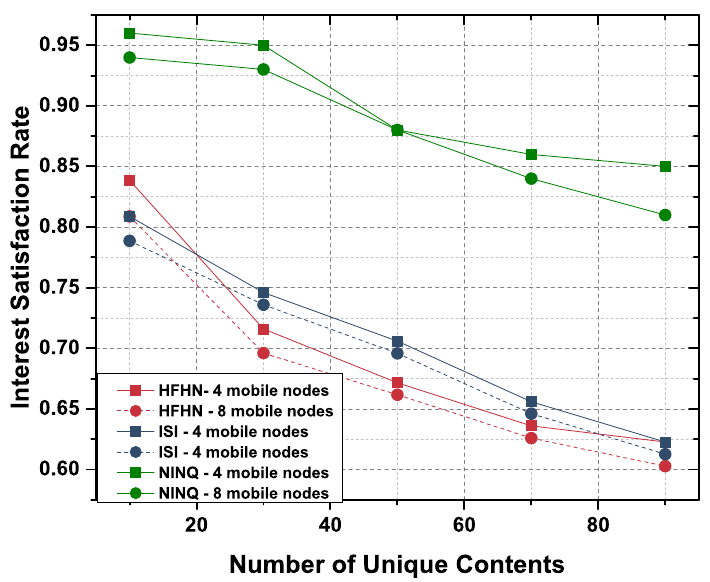
Figure 10. ISR in a network by number of unique contents.